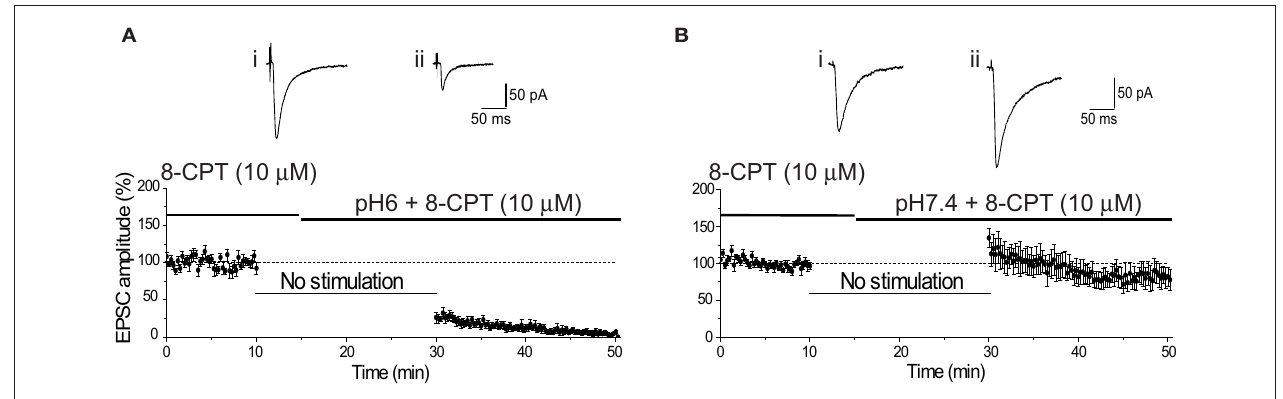
inhibition of the EPSC amplitude, comparable with that observed in the absence of 8-CPT. Representative EPSCs show the final baseline response (i) and the